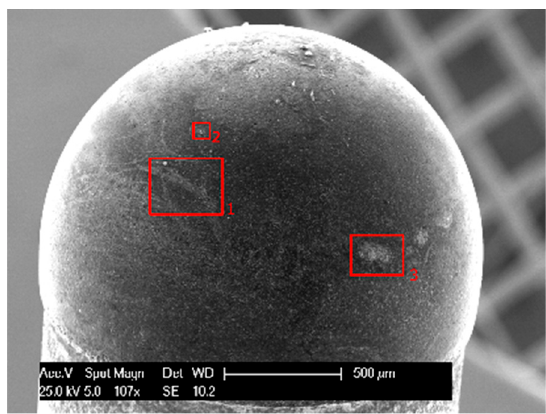
Figure 7. SEM overview of the used PCD-RB tooling.